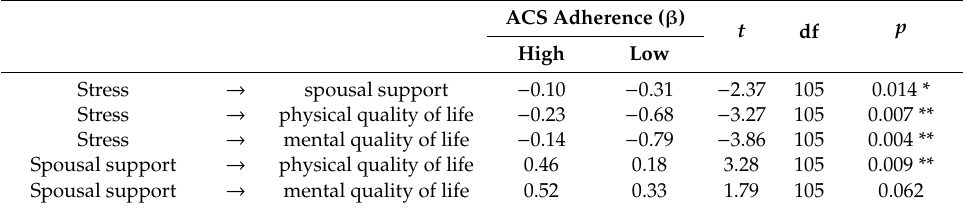
Table 5. Multiple group analysis results by ACS adherence (moderating e ff ect).